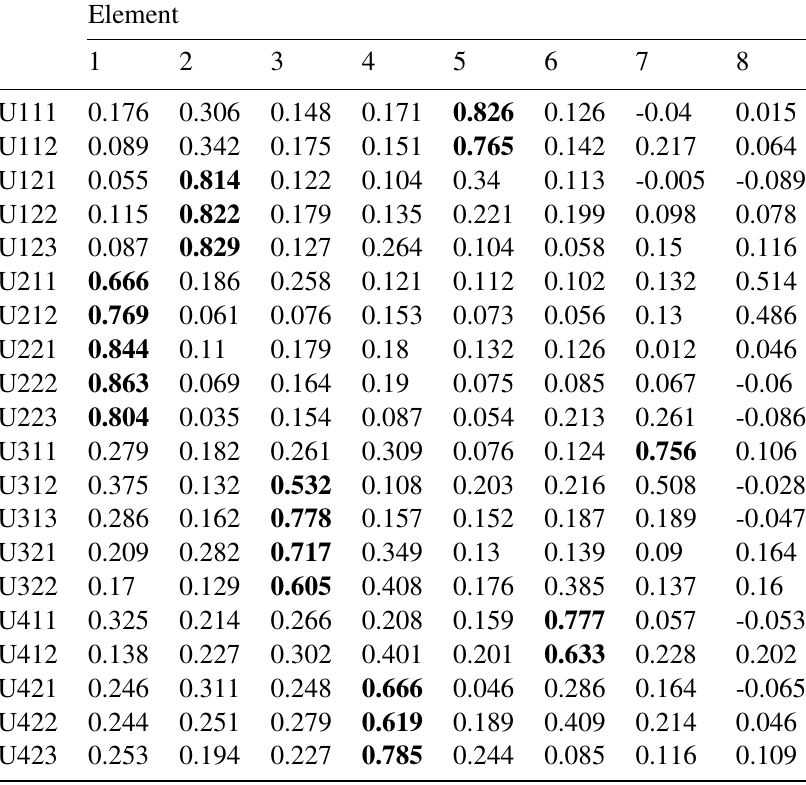
Table 1 Rotate Matrix result